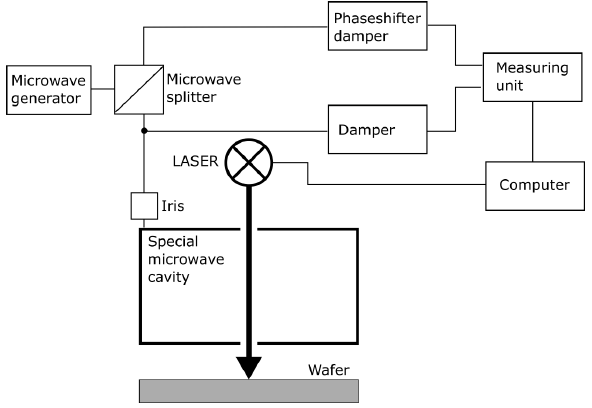
Figure 2. Schematic MDP measurement setup.